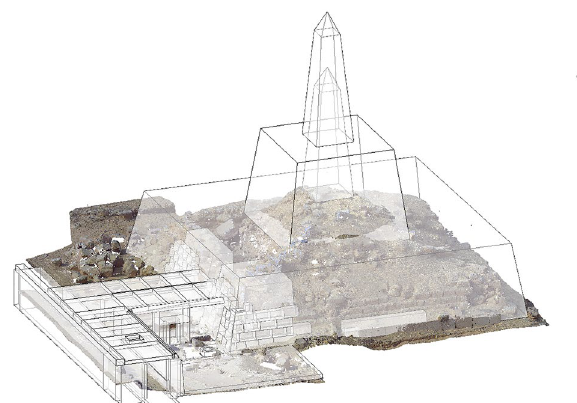
Figure 9: The comparison of the two-alternative hypothesis about the shape and height of the obelisk and truncated basement.